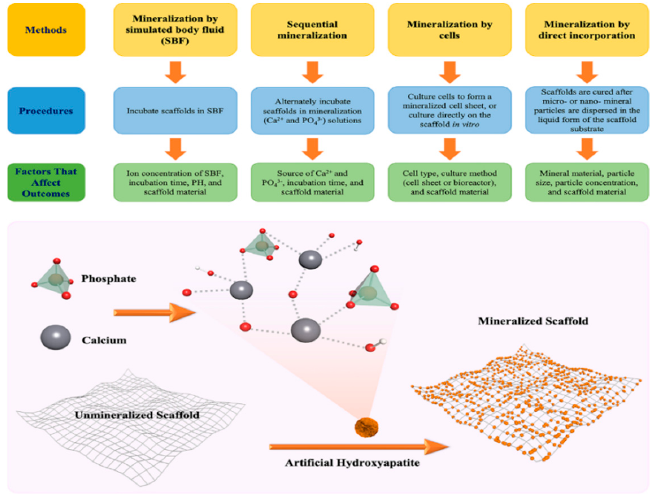
Figure 2. Flow chart for main methods of biomimetic mineralization.